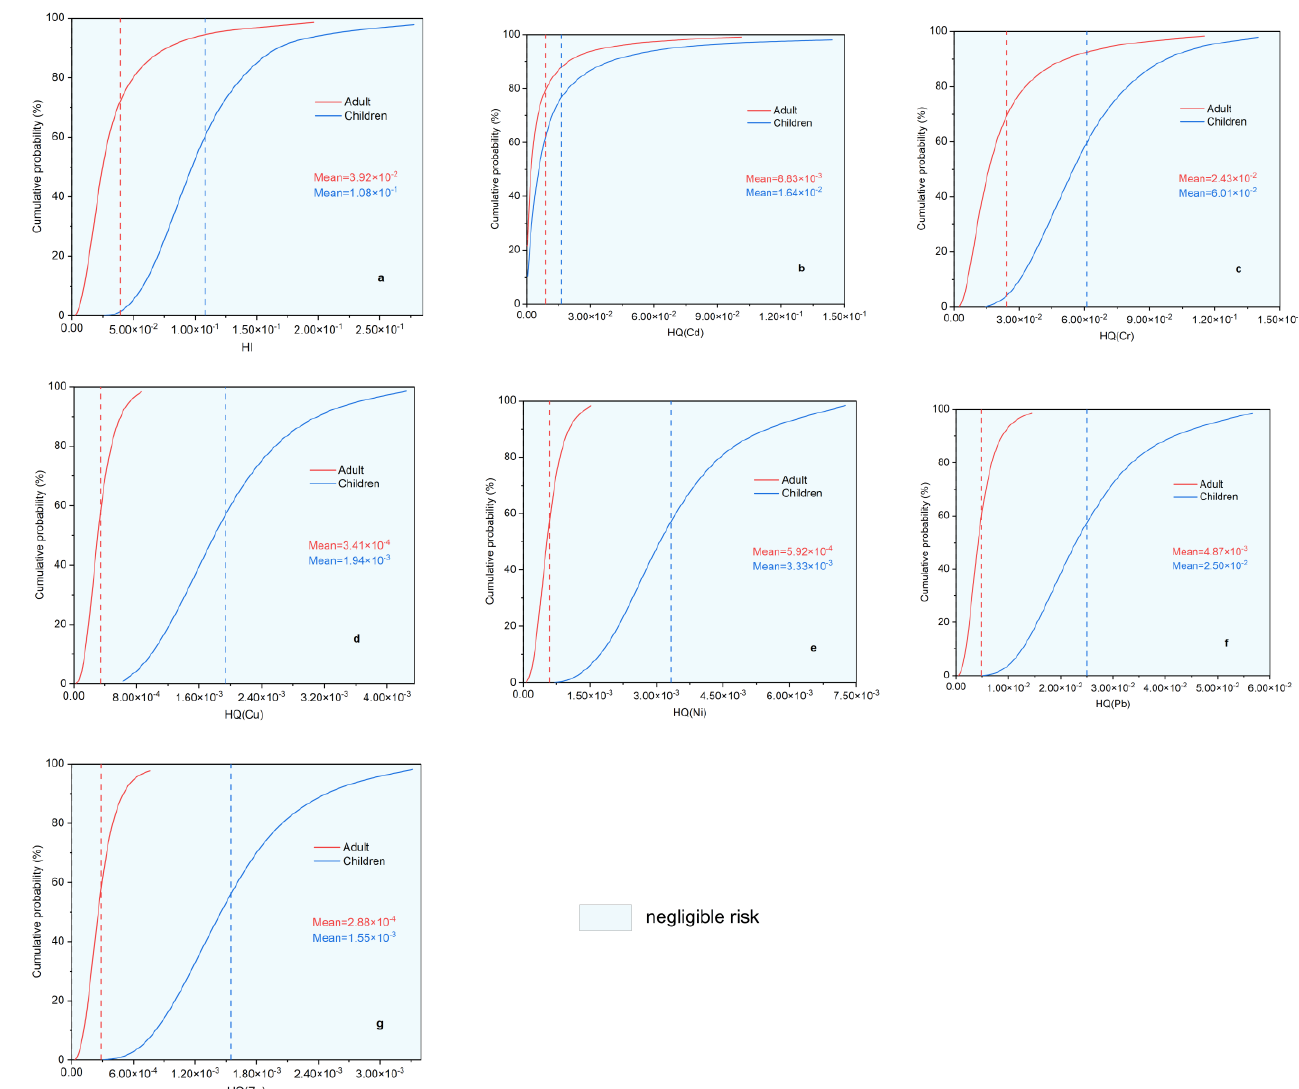
Figure 7. Probability distribution for ( a ) hazard index (HI) and hazard quotient (HQ) of ( b ) Cd, ( c ) Cr, ( d ) Cu, ( e ) Ni, ( f ) Pb, and ( g ) Zn. The red and blue vertical dashed lines represent mean values for adults and children, respectively.